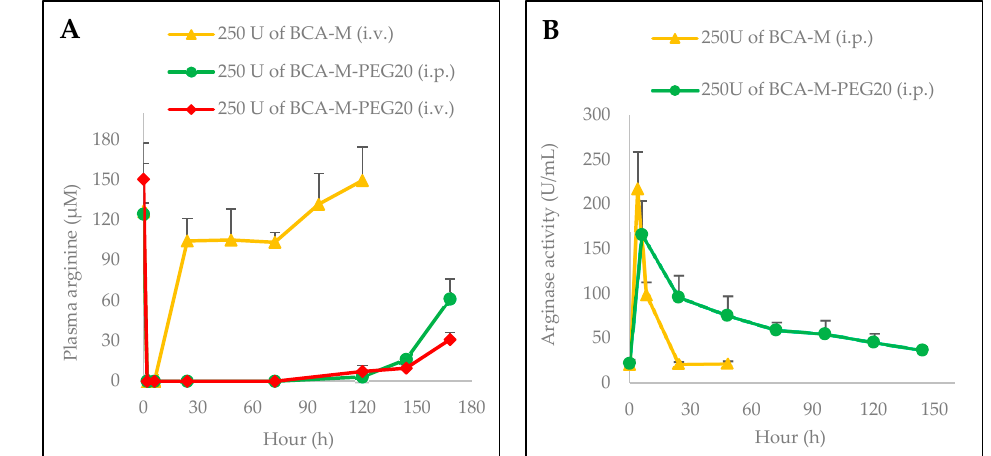
Figure 6. Pharmacodynamics ( n = 3) and pharmacokinetics ( n = 5) studies of BCA-M and BCA-M-PEG20 in normal BALB / c mice following a single i.p. and i.v. administration. Plasma was collected from saphenous veins in mice hind legs at the indicated time points. The concentrations of serum arginine ( A ) and arginase activity ( B ) were determined by amino acid analysis and QuantiChrom Urea Assay Kit, respectively. Results are presented as mean ± SEM.